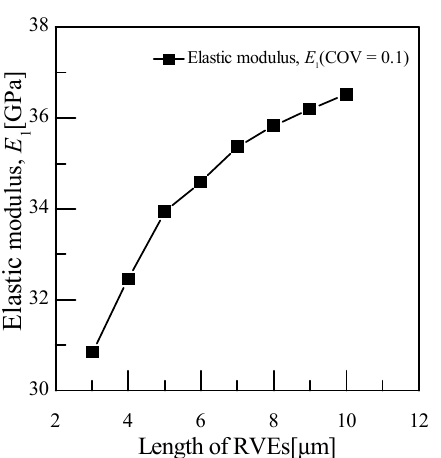
Figure 8. Variation in the effective properties according to the RVE length. It was identified that as the RVE length increases, E 1 also gradually increases. Accord- ingly, the effective properties of the RVE are using the relationship between the RVE length and CNT. It is necessary to determine this relationship for specifying the RVE length of the CNT/PVDF